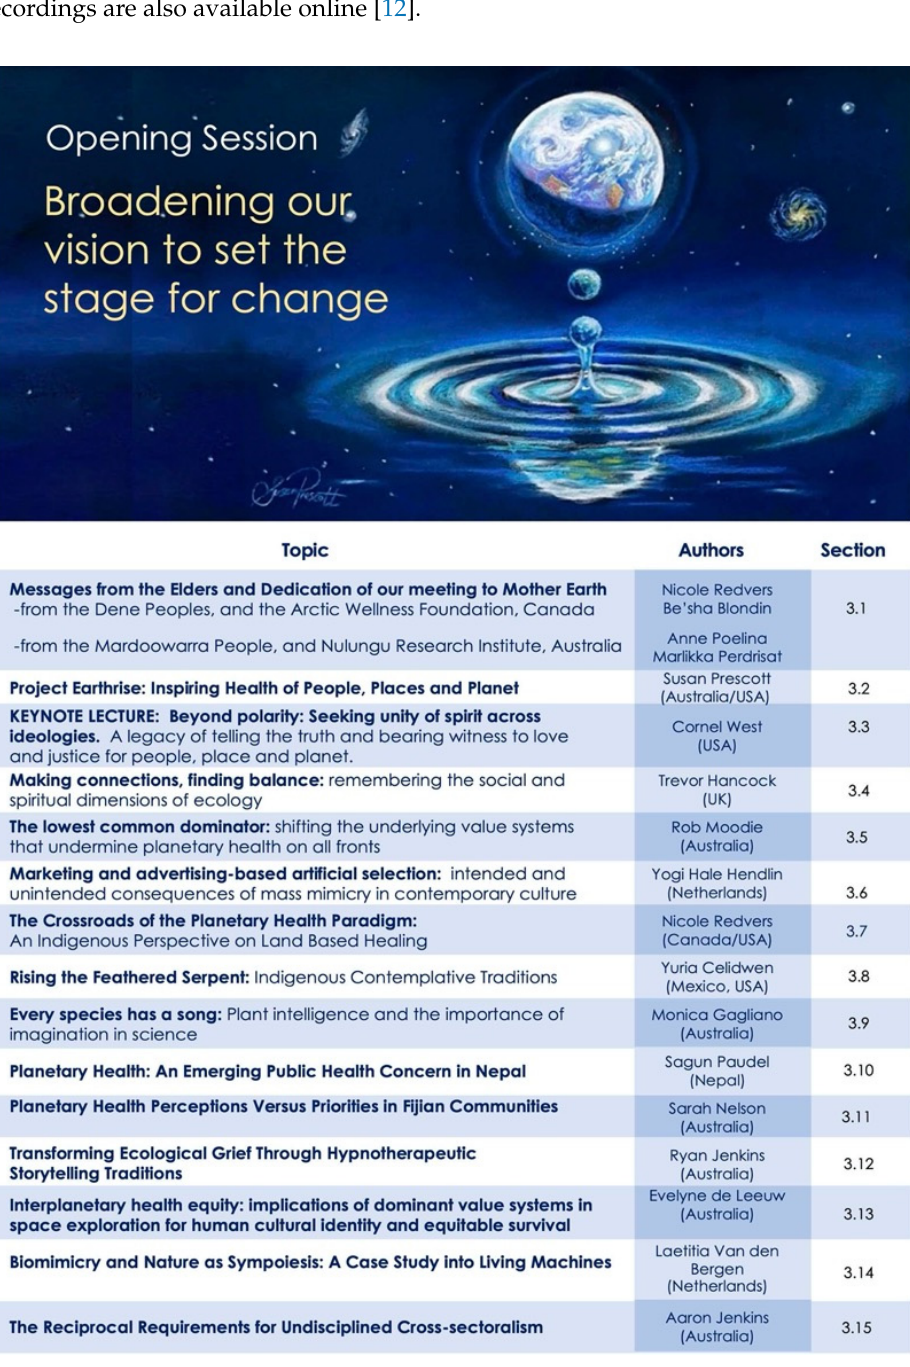
Figure 2. Broadening our vision to set the stage for change. Overview of topics and speakers in the opening session.